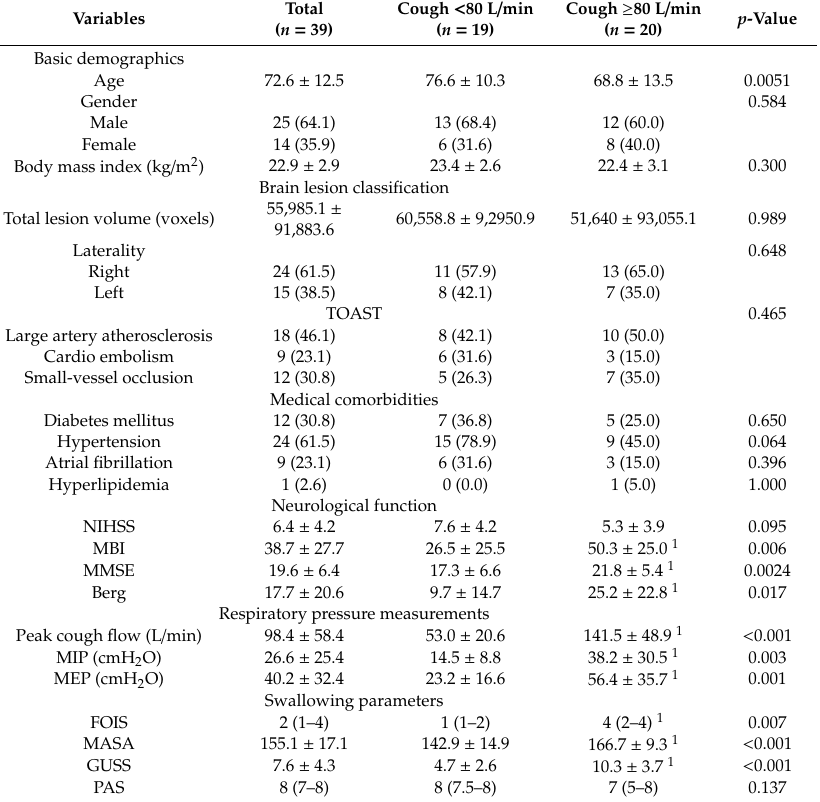
Table 1. Basic demographic and clinical